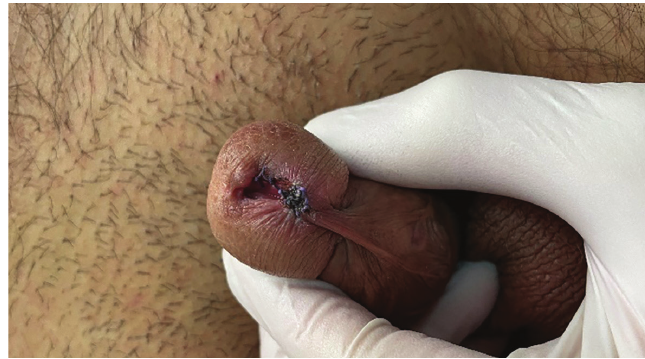
Figure 3 - Parameatal cyst appearance of the cyst in 7 days post- surgery.